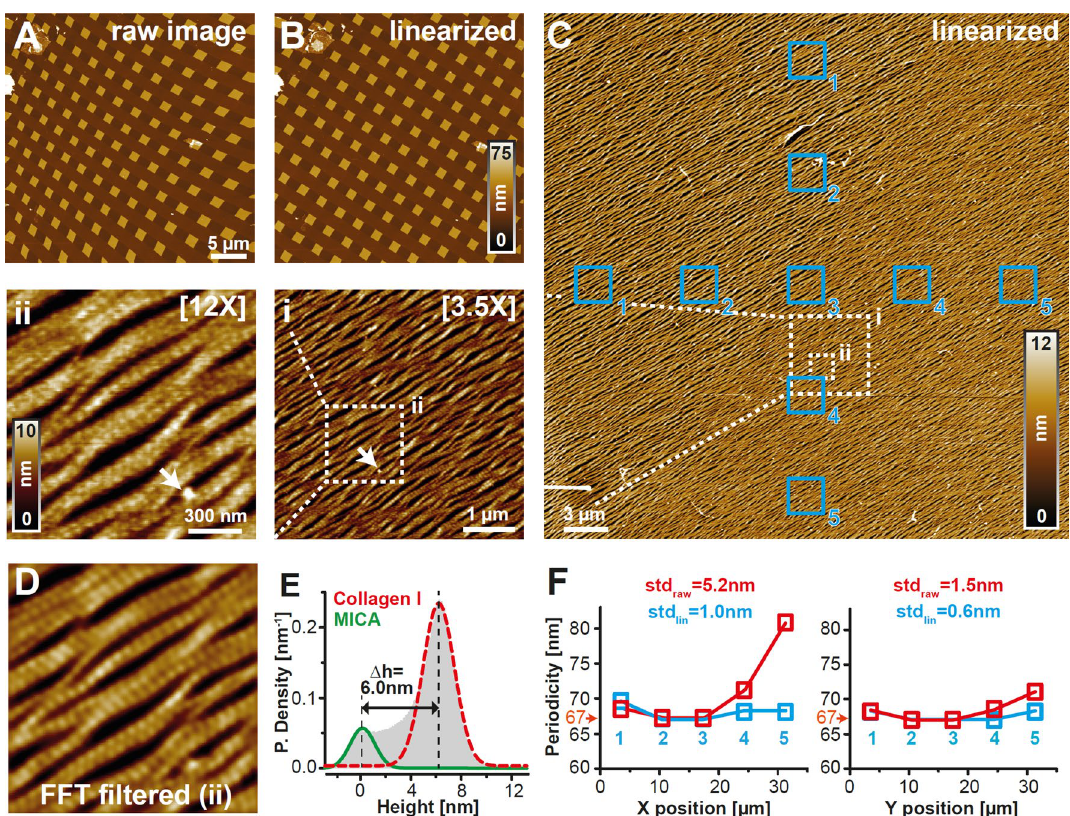
Figure 2. Scanner hysteresis compensation and full-width image quality at maximum spatial sampling. ( A ) AFM image of a test grid sample (3 µm pitch) without hysteresis compensation at 9 megapixels lateral sampling. ( B ) Same as ( A ) after hysteresis linearization using a fourth order polynomial fitting. ( C ) High-resolution 16 megapixel, full-width (35 × 35 µm 2 ) topography of a homogenous carpet of collagen I fibers recorded at 7 Hz line frequency, a tip surface speed of ~ 0.5 mm/s and at maximum DAC bandwidth (8.8 nm/pixel). Serial enlargements of boxed areas are shown in ( i ) and ( ii ), corresponding to a zoom of 3.5× and 12×, respectively. The topography was recorded in buffer solution (pH 9.2, 50 mM glycine, 200 mM KCl) at room temperature. ( D ) The 12× enlargement of the collagen topography shown in ( ii ) was processed through FFT mask filtering to emphasize the characteristic collagen D-band periodicity. ( E ) Normalized height distribution of the collagen I topography shown in ( C ). The two peaks were fitted with the sum of two Gaussian functions, separating mica (solid green line) and collagen I fibril (dashed red line) height distributions. ( F ) D-band periodicity values were determined within 2 × 2 µm 2 ROIs at different positions indicated in ( C ) along the x- (left panel) and y-axis (right panel) before (red) and after (blue) image linearization. After linearization, periodicity values throughout the frame are close to the expected value of ~ 67 nm, demonstrating high image homogeneity throughout the full travel-range of the piezo actuators. Individual ( A – C , D ) and plots ( E , F) were generated using ImageJ 1.52e (https:// imagej. nih. gov/ ij/ index. html) and/or Matlab 2020b (https:// it. mathw orks. com/ produ cts/ matlab. html). Final figure was assembled, edited, and rendered with Adobe Creative Cloud suite (https:// www. adobe. com/ creat ivecl oud.